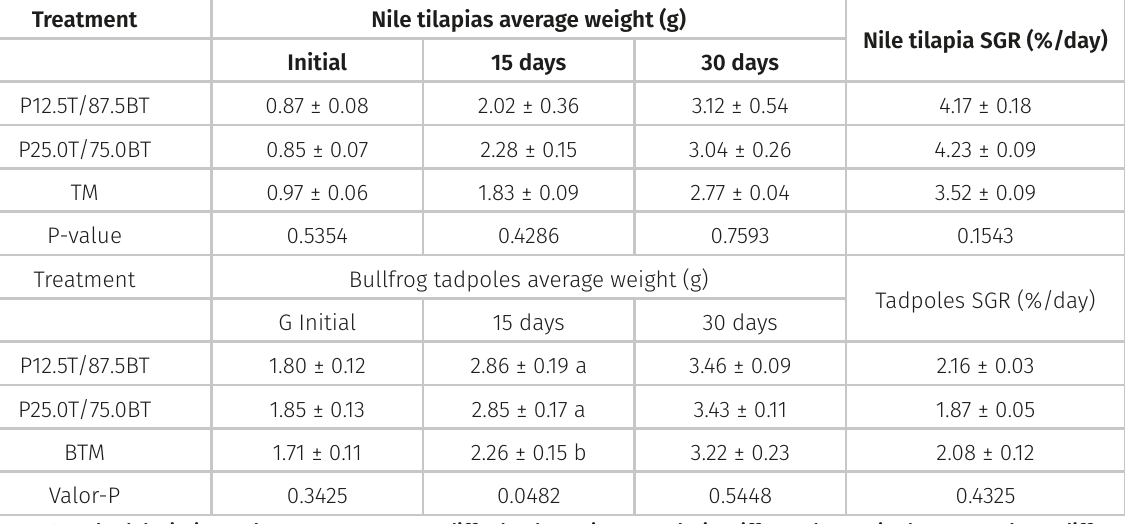
Table V. Total biomass of Nile tilapias (T) fingerlings and bullfrog tadpoles (BT) in polyculture, tilapia monoculture (TM) and a bullfrog tadpole monoculture (BTM) breeding in the experiment 2.